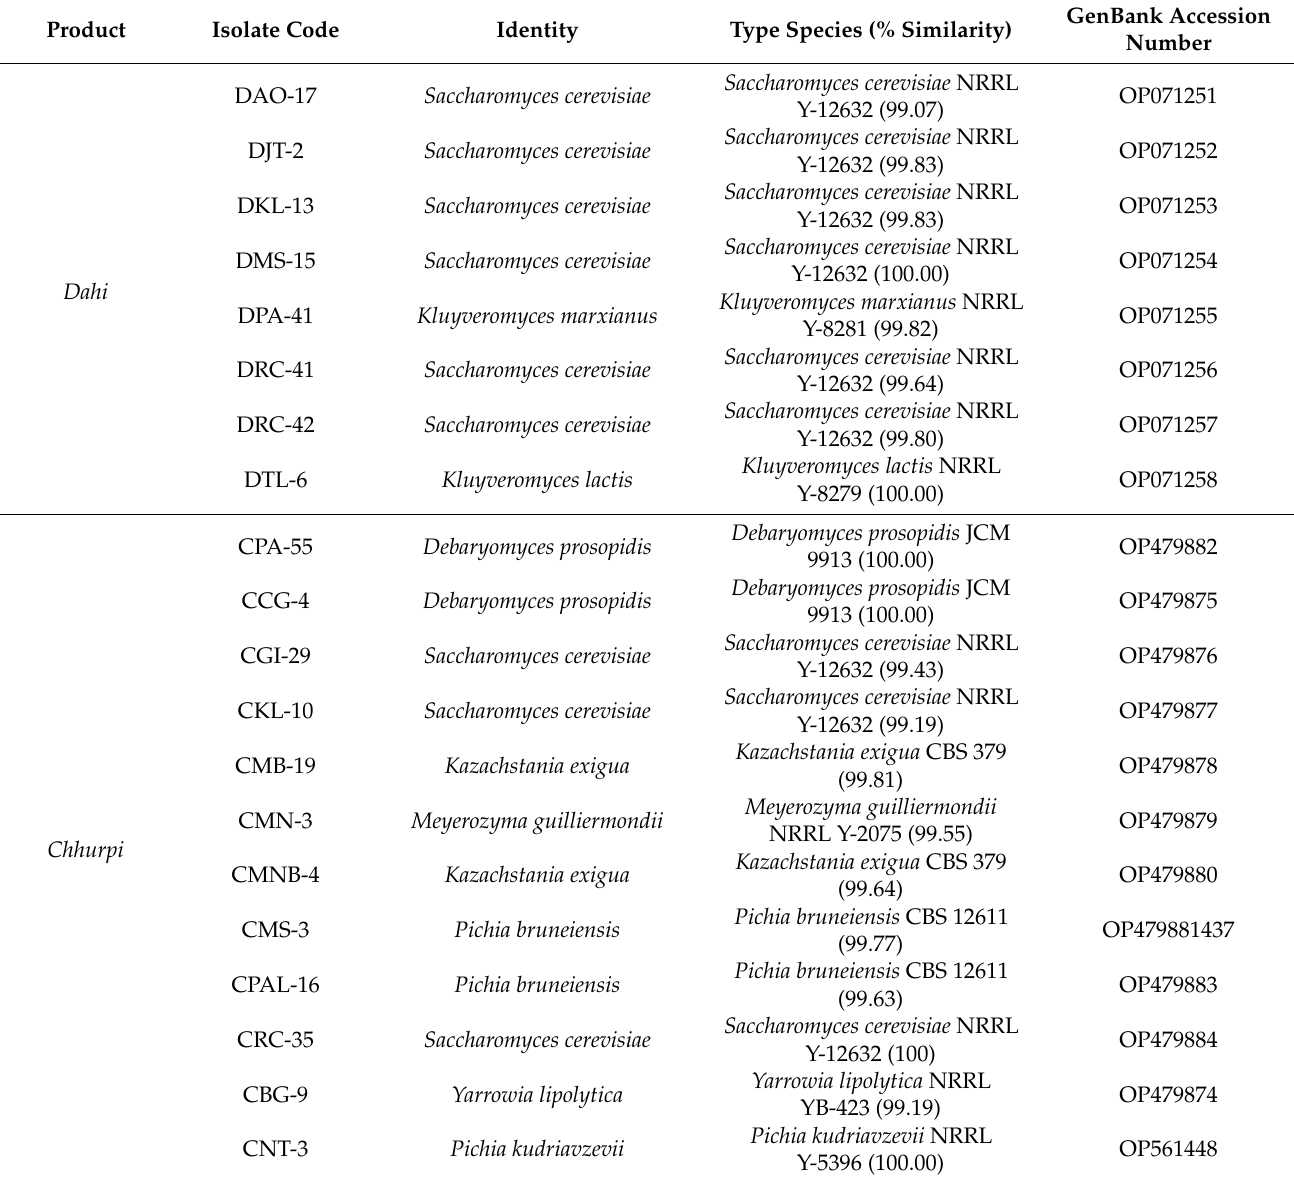
Table 4. Molecular identification of probiotic yeasts strains isolated from dahi and chhurpi of Sikkim, based on sequencing of the D1/D2 domain of a large ribosomal